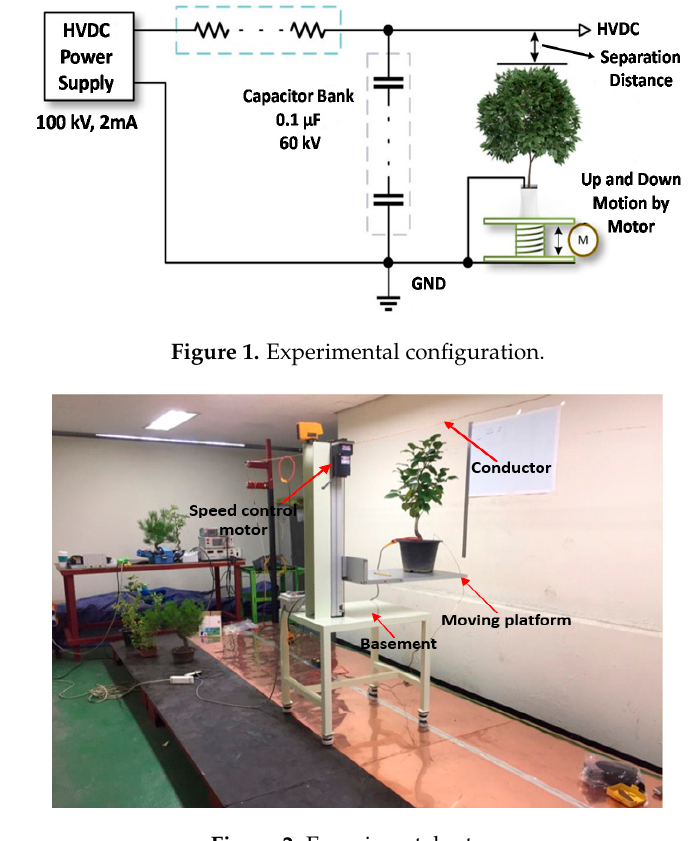
Figure 2. Experimental setup.